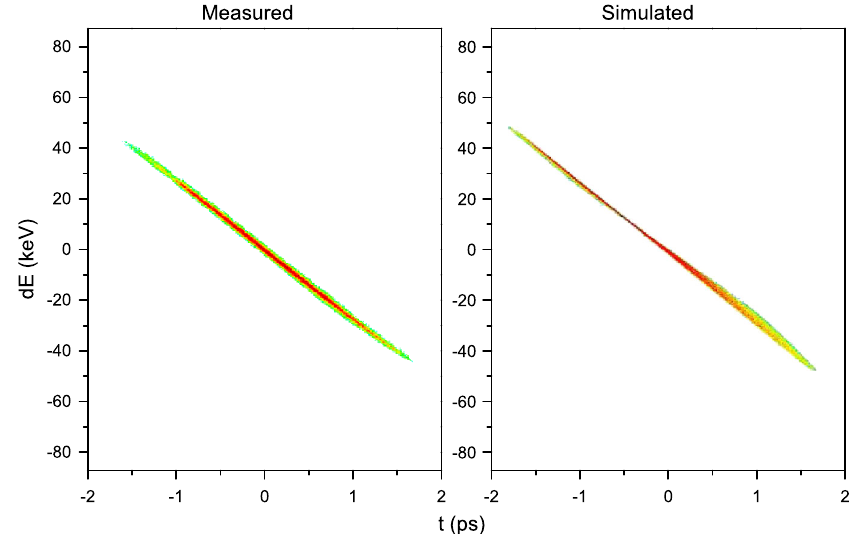
FIG. 3. (Color) Single shot LPS measurement compared with simulation. The filtered image data (shown on the left) has time on the vertical axis and the energy on the horizontal axis. The right figure shows the simulated results of the LPS by general particle tracer.